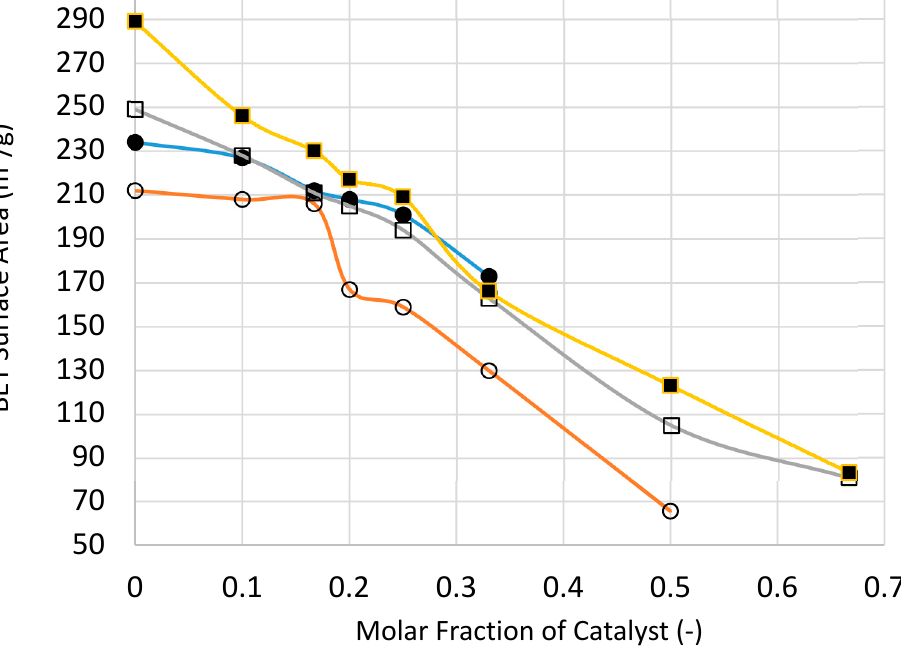
Figure 25. The effect of catalyst loading on the surface area of the supported nickel catalyst system before reduction with hydrogen after the formation of NiO. ( ● )—Microwave radiation at 1 kW (Stage ‐ 1a); ( ○ )—Thermal processing at 300 °C with slow heating and slow cooling using Method ‐ A, Section ‐ 3.8 (Stage ‐ 1b); ( □ )—Thermal processing at 600 °C with fast heating and fast cooling using Method ‐ B, Section 3.8 (Stage ‐ 1c); ( ■ )—Thermal processing at 600 °C with slow heating and slow cooling using